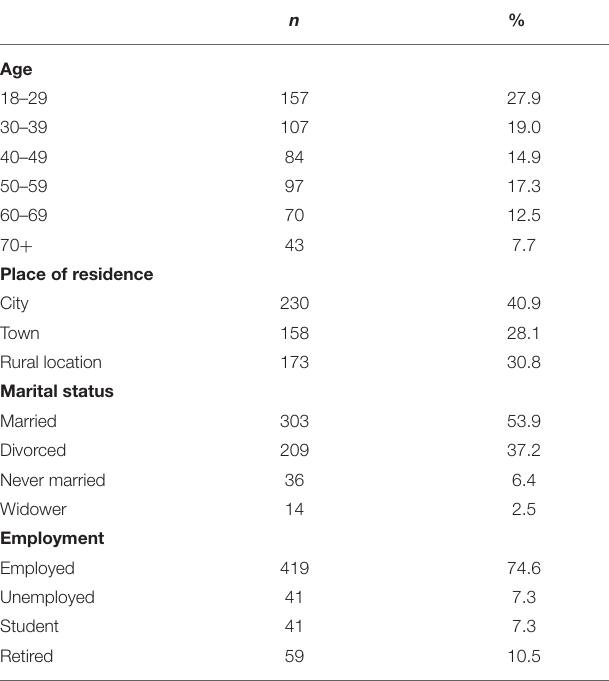
TABLE 1 | Sociodemographic characteristics of the sample. TABLE 2 | Means, standard deviations of the variables and correlation coefficients.